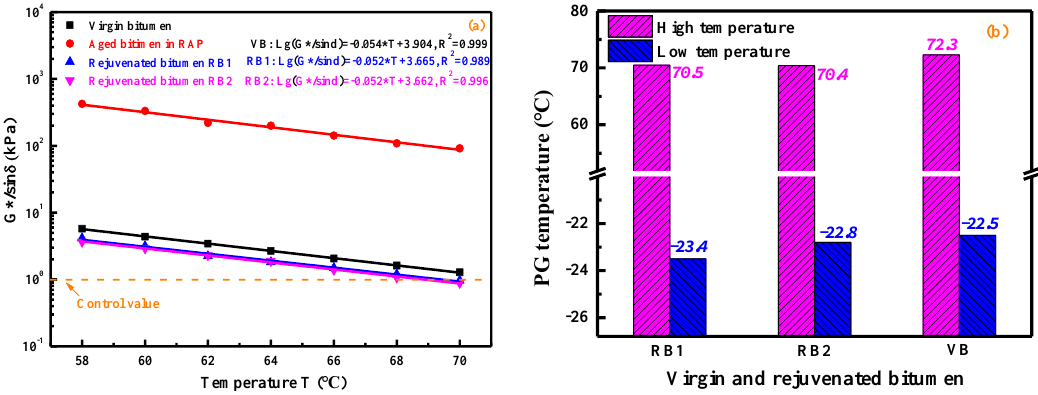
Figure 15. The rutting factor and PG grade of virgin and rejuvenated bitumen.